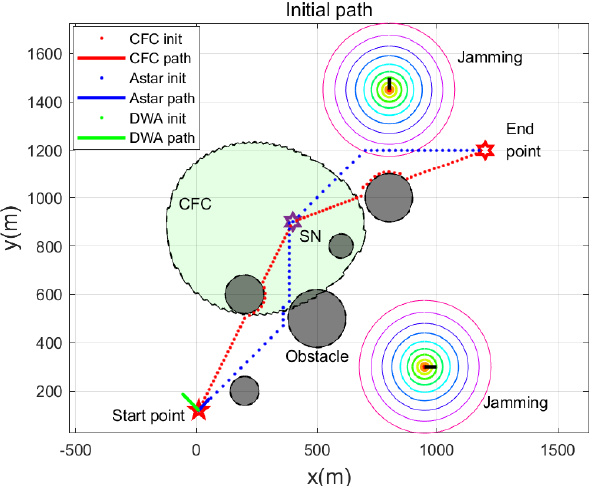
Figure 5. 200 kbit data collection with three algorithms for motion planning in environments without jamming and with static and dynamic jamming.